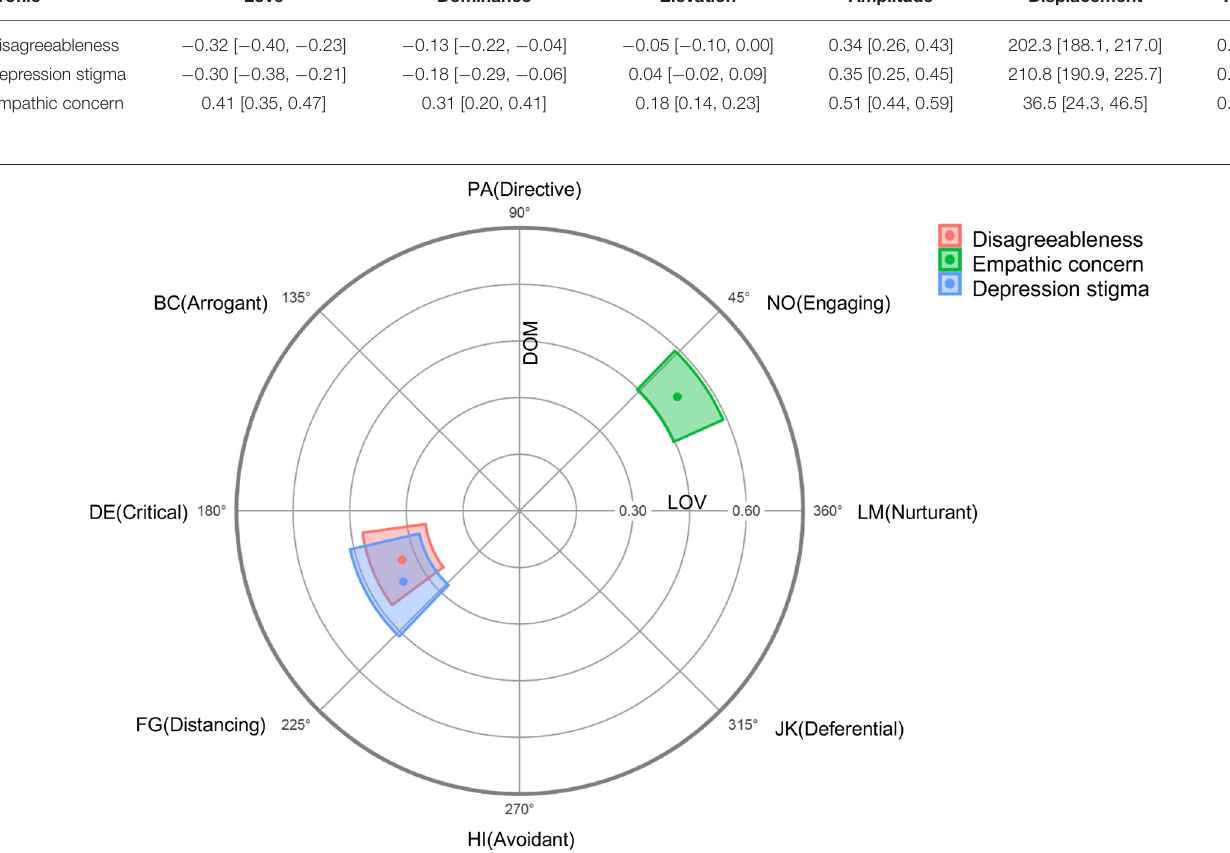
empathic concern ( r = − 0.30, p < 0.001). As expected, stigma was associated with less empathic concern ( r = 0.34, p <